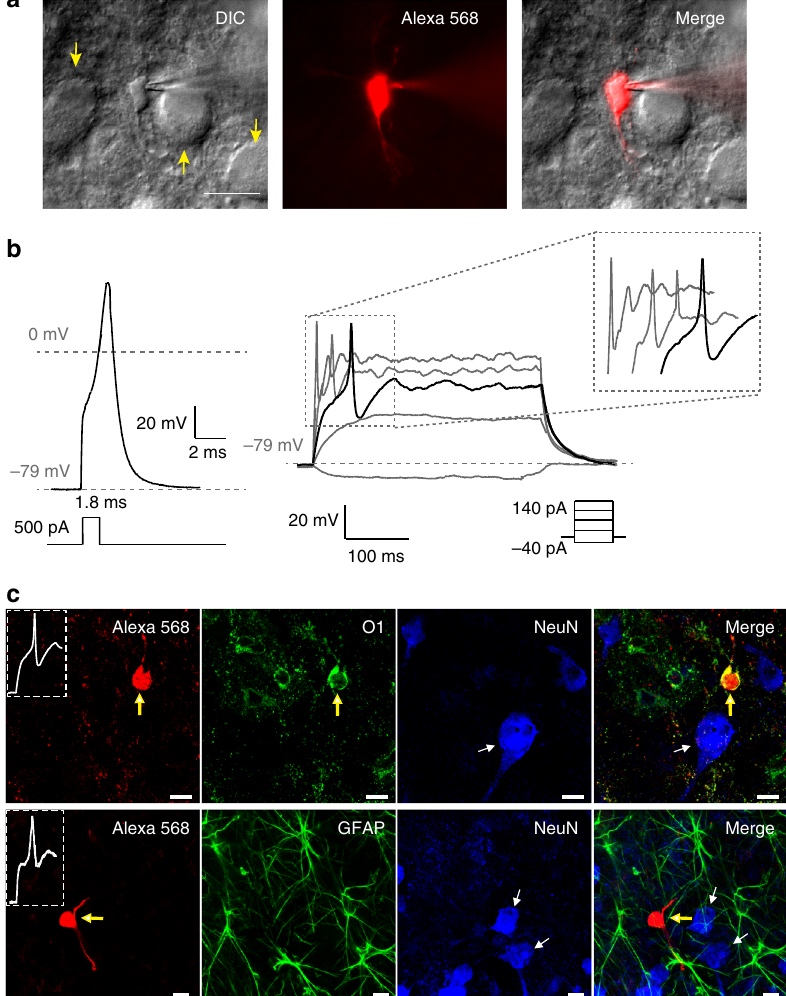
Fig. 1 A subpopulation of MNTB OLs can fi re APs. a Excitable OLs in the MNTB were subjected to whole-cell patch-clamp recording and were fi lled with Alexa 568 ( red ) during recording for post-recording immunostaining. Differential interference contrast (DIC) image of an excitable OL, which was loaded with Alexa 568 ( red ). Yellow arrows indicate MNTB principal neurons. Scale bar , 20 μ m b A single AP was generated by a brief current injection (500 pA for 1.8 ms, left ) in an excitable OL at P11. APs were evoked by step-current injections from − 40 to 140 pA (300 ms, right ) in the same cells. Inset , expanded time scale of area within the dashed box. c Upper Excitable OLs were immunostained for O1 (OL marker; green ) and NeuN (neuronal marker; blue ). A representative excitable OL displayed APs (inset) and expressed O1 ( yellow arrow ) but not NeuN ( white arrow ). Lower Excitable OLs were immunostained for GFAP (astrocyte marker; green ) and NeuN ( blue ). A representative OL expressed neither GFAP nor NeuN ( white arrow ). Scale bar , 10 μ